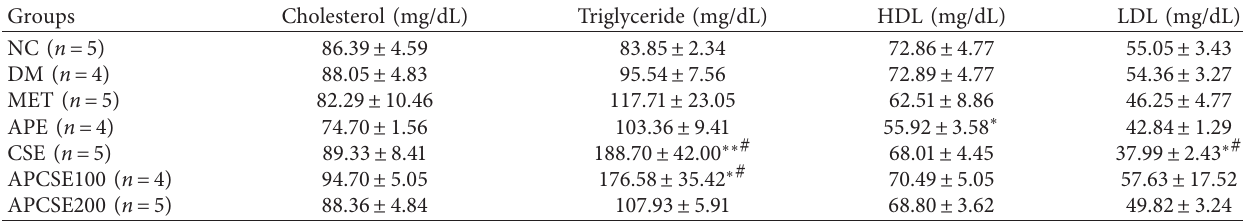
Table 1: Lipid profiles after